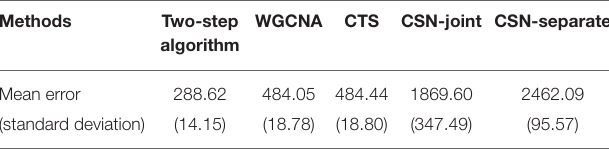
TABLE 1 | Mean errors and corresponding standard deviations of five methods.